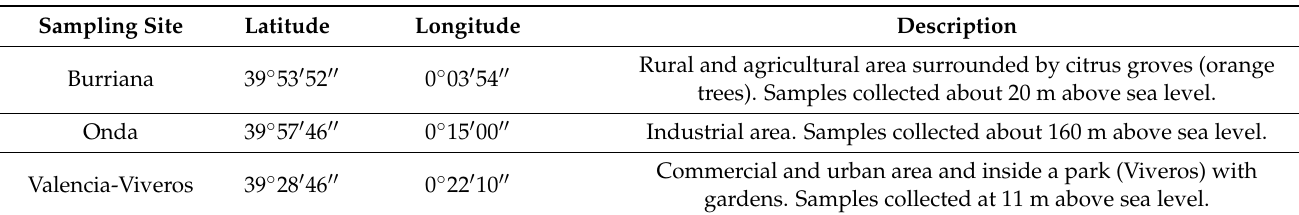
Table 1. Description of sampling sites of PM 10